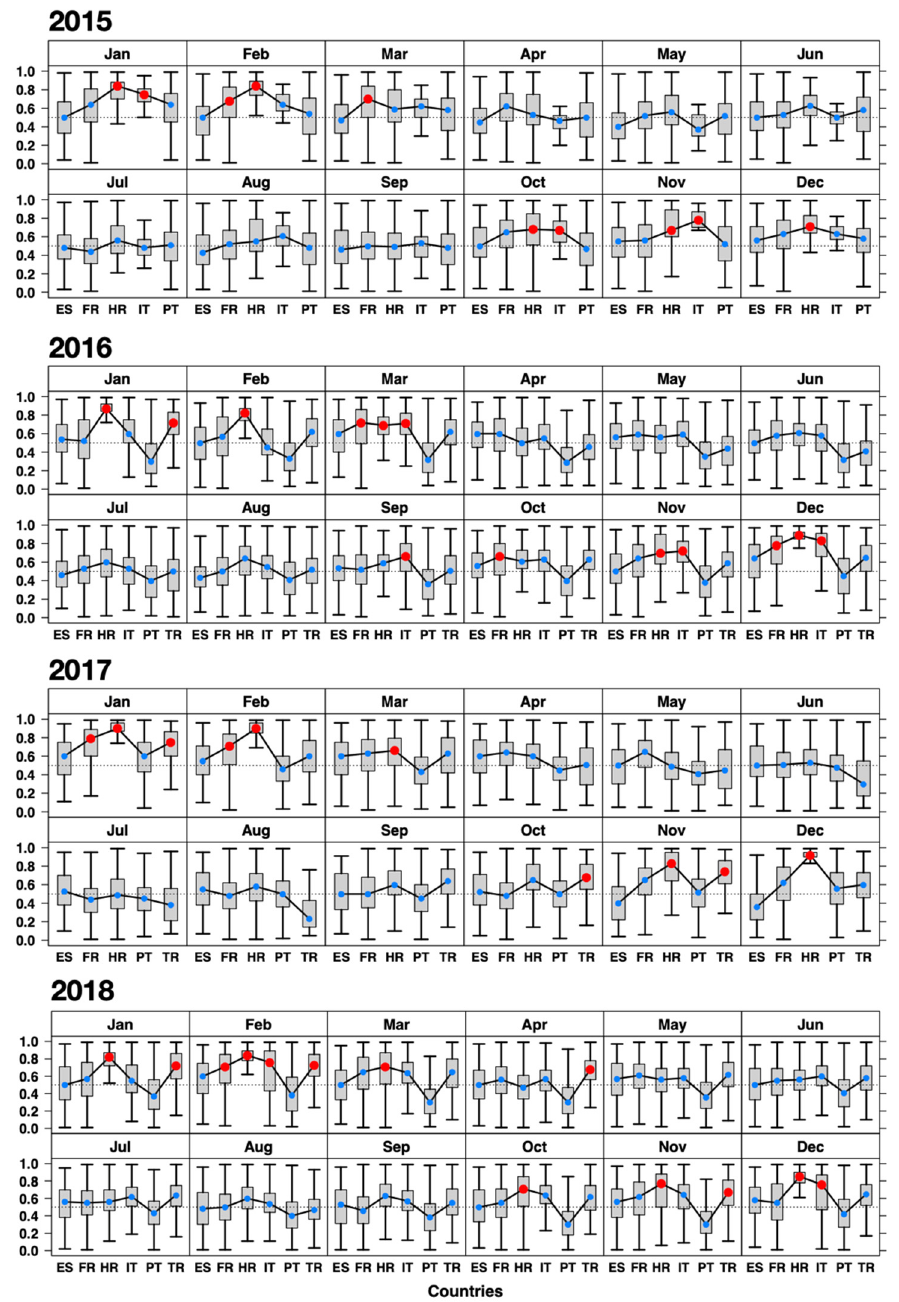
Figure 3. Monthly distribution of PM 2.5 /PM 10 ratios as in Figure 2. As a reference, countries exceeding the 0.65 ratio in 50% of the data are indicated by a red median, otherwise in blue. ES—Spain; FR—France; HR—Croatia; IT—Italy; PT—Portugal; TR—Turkey.